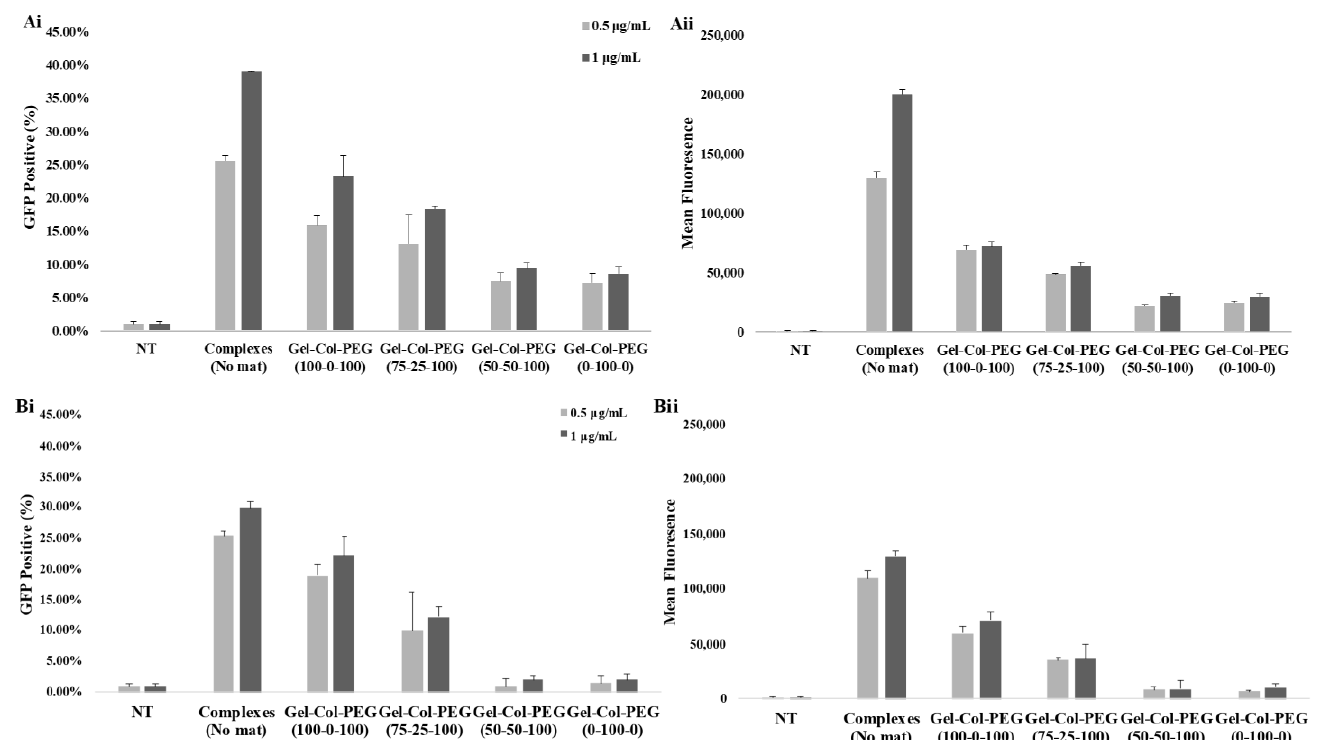
Figure 4. In vitro transfection in C2C12 ( Ai , Aii ) and MC3T3 ( Bi , Bii ) cells analyzed 48 h post-transfection by flow cytometry. The different volume Gelatin-Collagen-PEG mats were loaded with GFP complexes. The GFP concentrations in cell culture medium were 1.0 and 0.5 μg/mL. NT: no treatment.